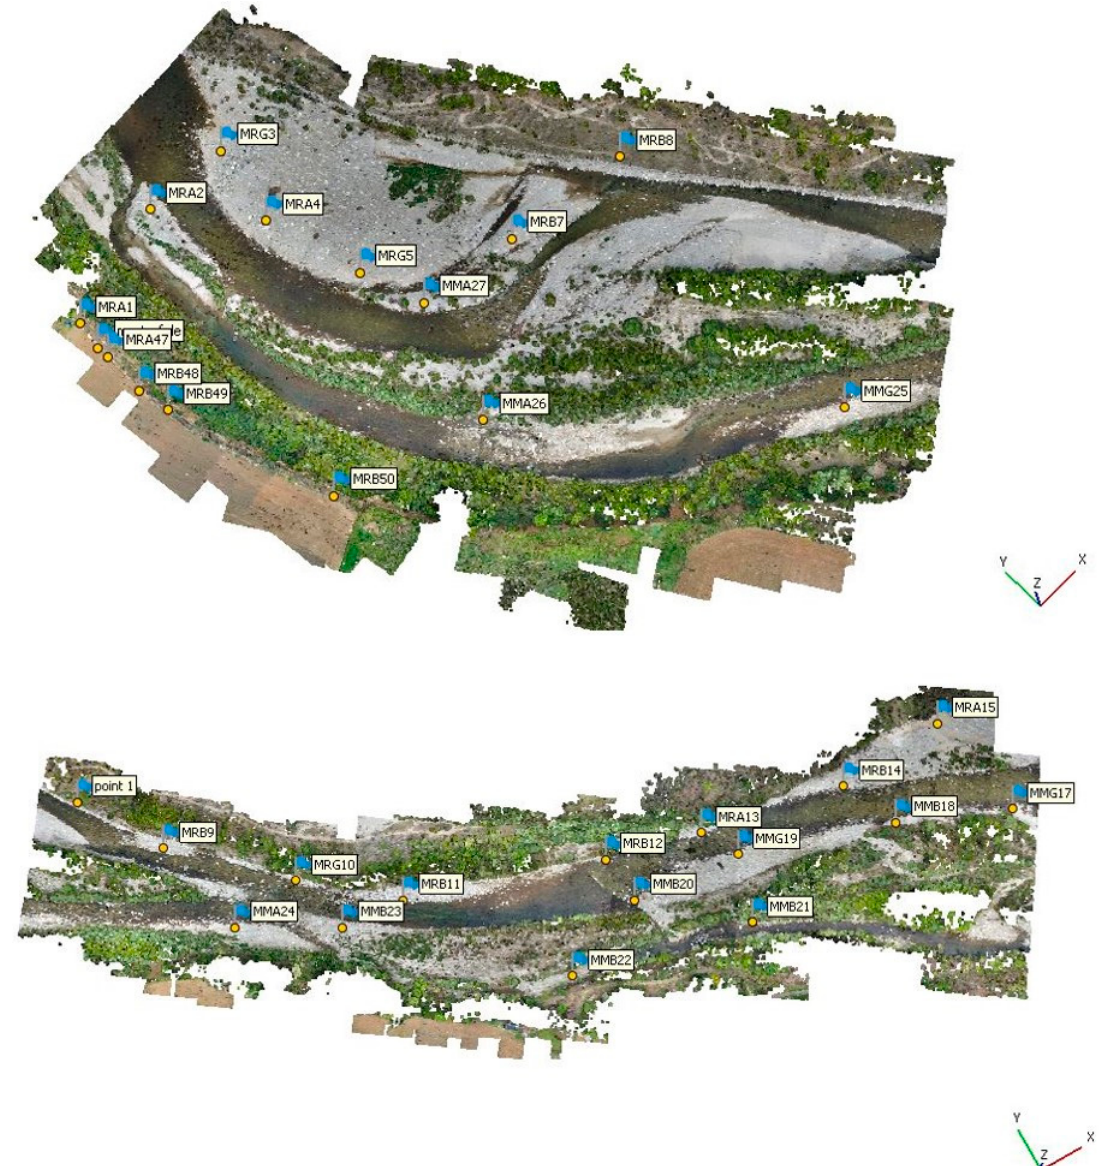
Figure 9. Training and testing dense point clouds.